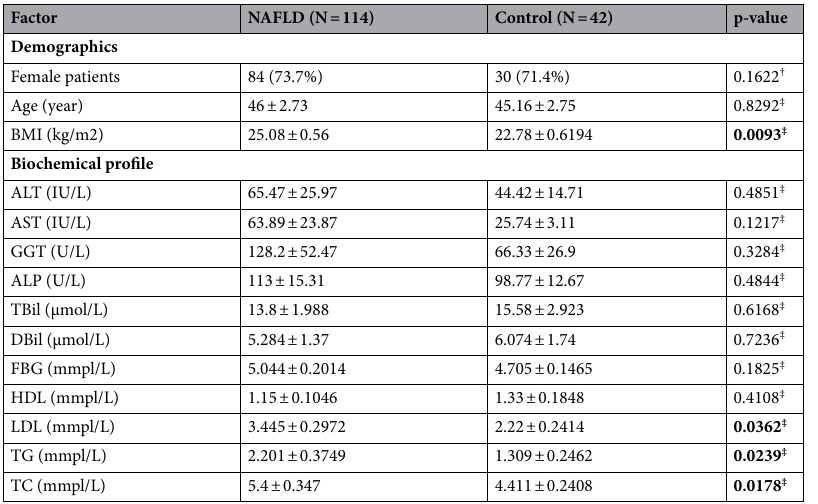
Table 1 . Demographic and clinical characteristics of subjects. Values presented as mean ± standard deviation or N (column %). BMI body mass index, ALT alanine aminotransferase, AST aspartate aminotransferase, GGT gamma-glutamyl transferase, ALP alkaline phosphatase, Tbil total bilirubin, Dbil direct bilirubin, FBG fasting blood glucose, HDL high-density lipoprotein, LDL low-density lipoprotein, TG triglycerides, TC total cholesterol, NAFLD non-alcoholic fatty liver disease. p-values: † Pearson’s chi-squared test, ‡ Student’s t ‐ test.